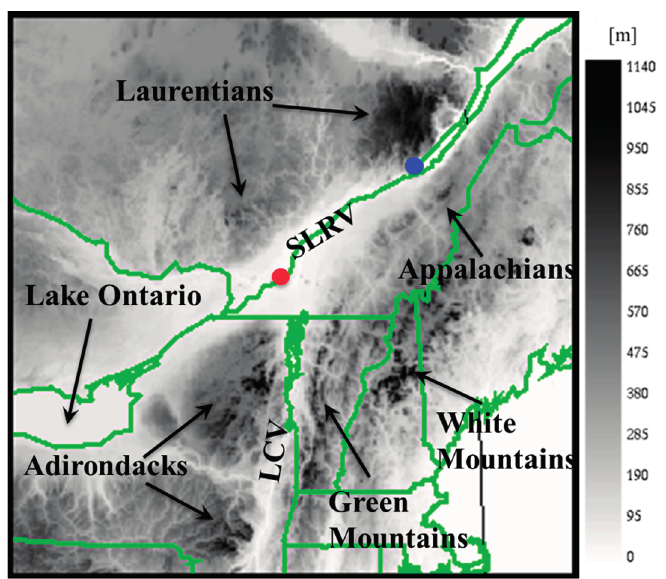
Figure 1. Geographical details of the study domain. The St. Lawrence River Valley (SLRV), Lake Champlain Valley (LCV), Lake Ontario and the Laurentian, Appalachian, Adirondack, Green and White mountains are indicated. The red and blue dots indicate the locations of Montréal and Québec City, respectively. Topographic height (meters) is shown by grey